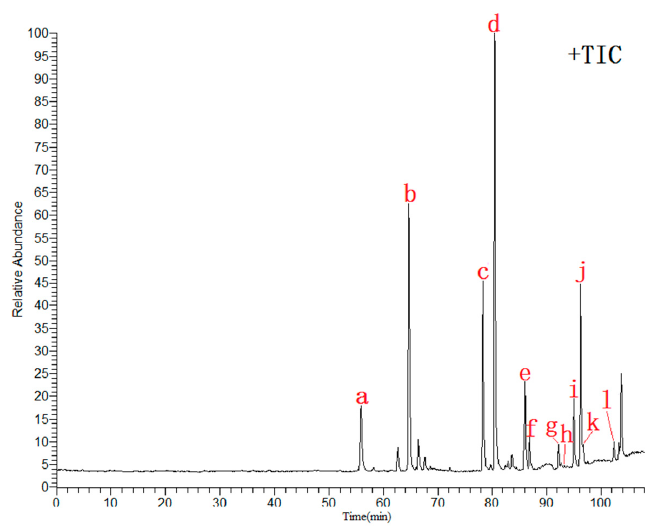
Figure 9. Total ion chromatogram of the reference substances in positive ion mode (a. Liquiritin; b.